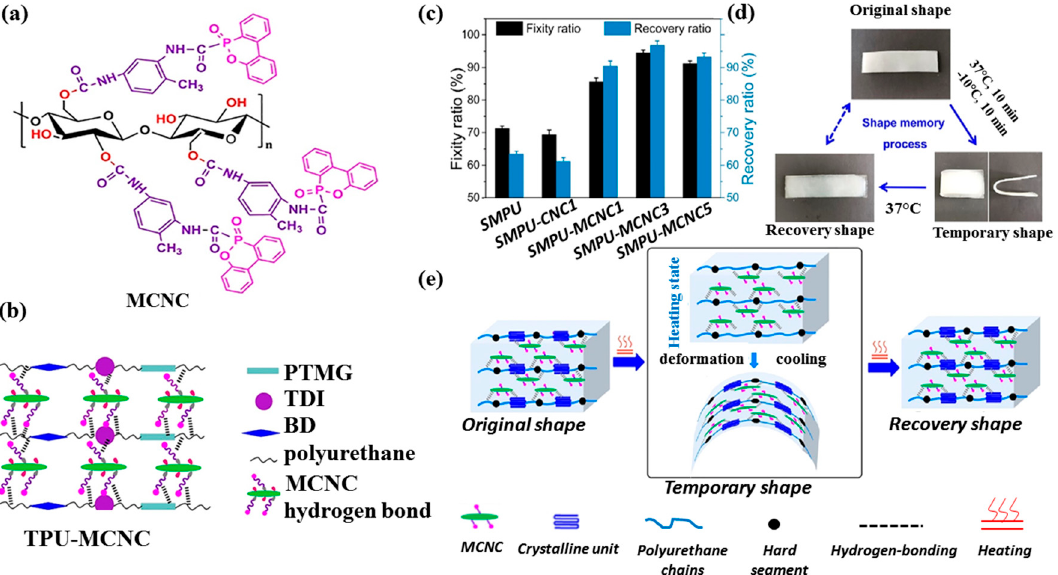
Figure 8. Structure of MCNC by in situ polymerization ( a ), composite production ( b ), shape memory behaviors (i.e., shape fixity and shape recovery ratios) of TPU and composites films ( c ), photographs showing the thermal-induced shape memory process of the representative TPU − MCNC3 film ( d ), schematic showing the possible mechanism of the thermal-induced shape memory behavior of TPU − MCNC composite ( e ). Adapted from [130].